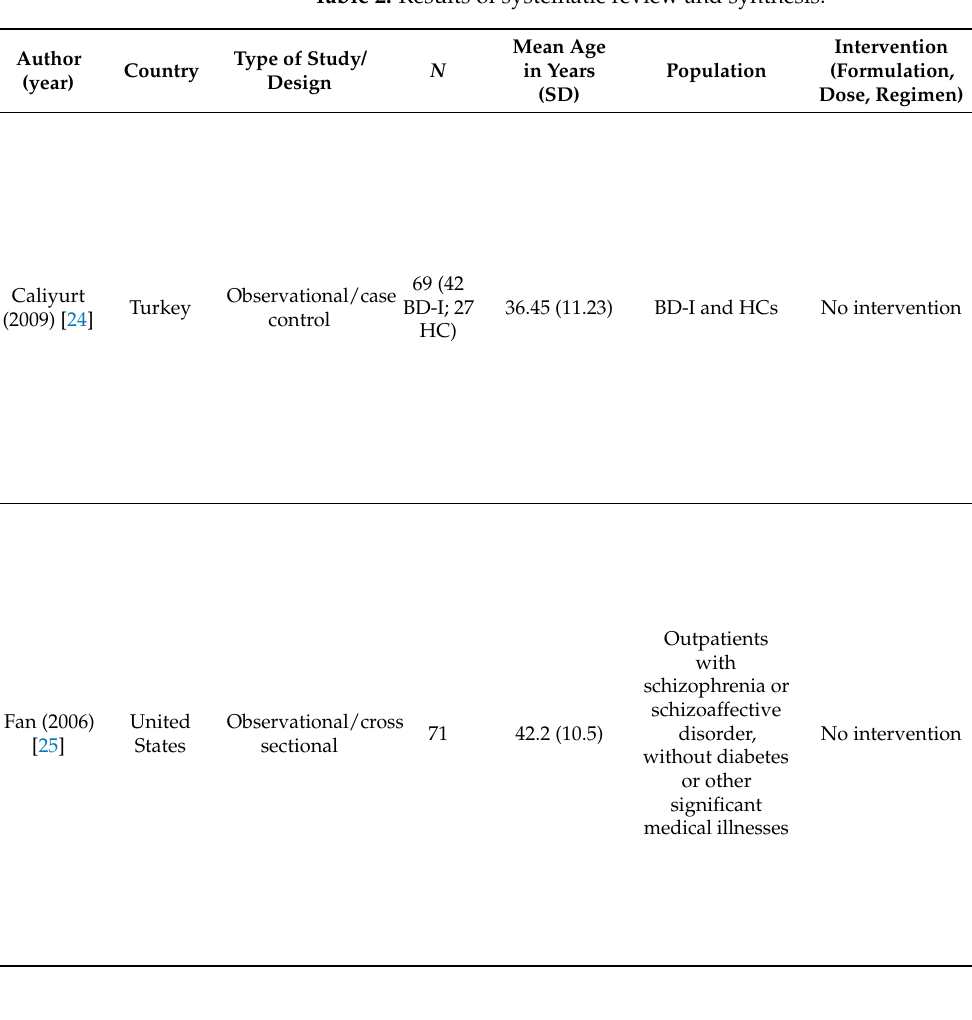
Table 2. Results of systematic review and